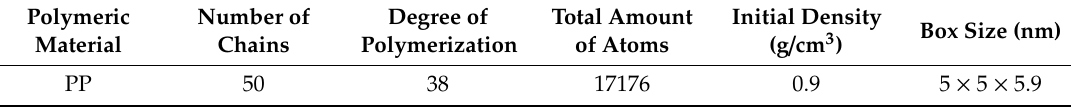
Table 1. Main parameters of polypropylene (PP) atomistic models.